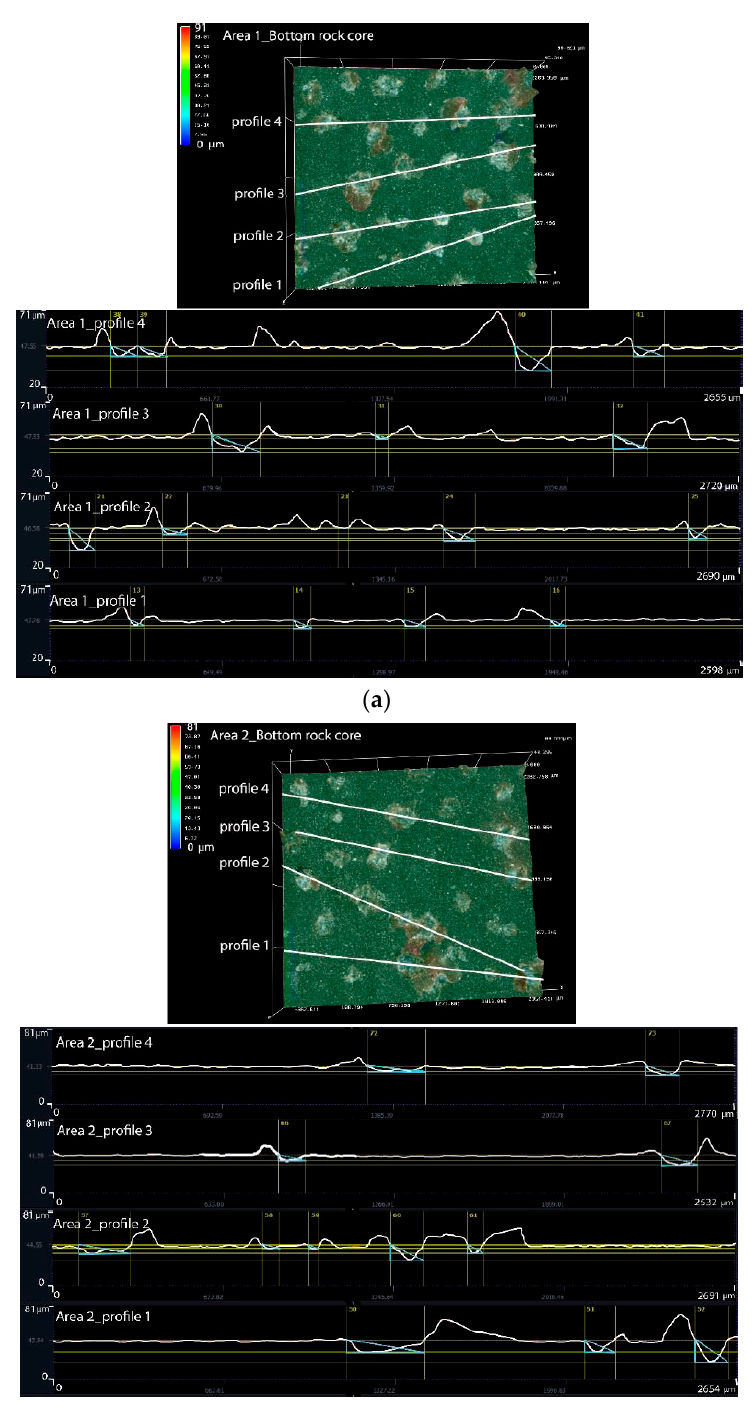
Figure 13. Average depth H e plug (Test 1): ( a ) Area 1; ( b ) Area 2.